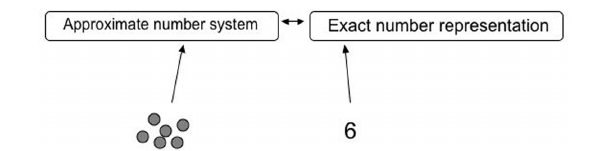
FIGURE 1 |A two semantic number representation model with an approximate representation for non-symbolic numbers and an exact representation for symbolic